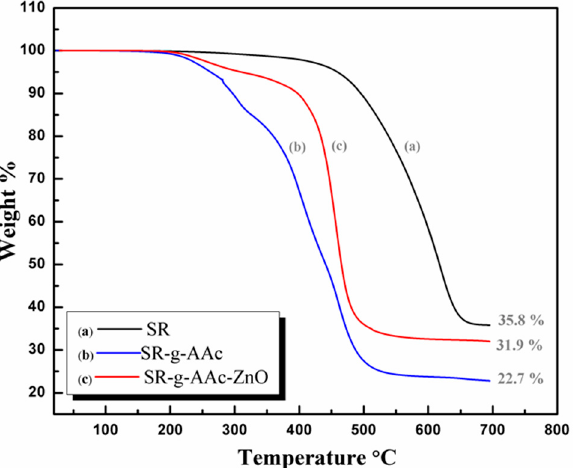
Figure 6. Thermogravimetric analysis of treated silicone with immobilized ZnO NPs. (a) Thermo- gravimetric analysis (TGA) of SR showing thermal stability below 400 °C; (b) Thermogram change after PAAc grafted on silicone (SR-g-AAc) showing additional two decomposition steps and proving the successful grafting of PAAc, (c) Thermogram of SR-g-AAc-ZnO showing better thermal stability after immobilization of ZnO NPs on grafted silicone.